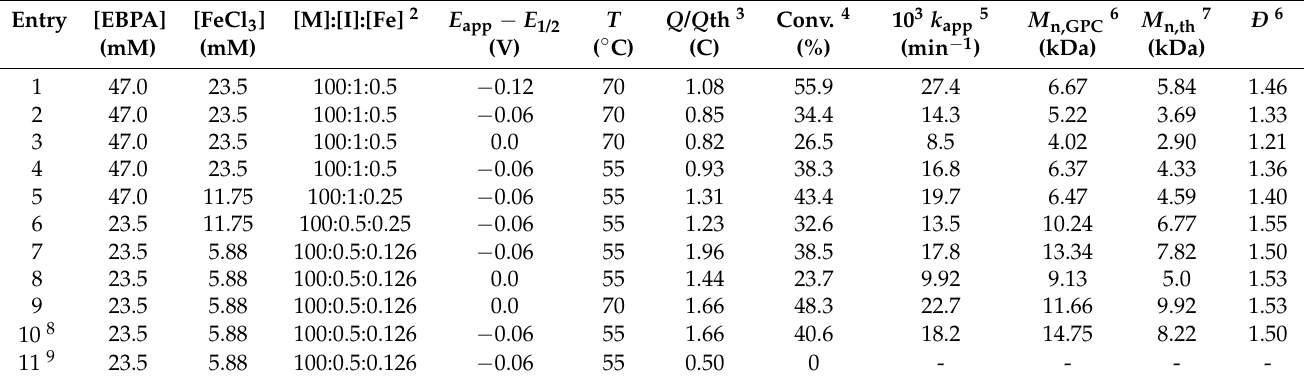
reaction rate. As desired, the conversion increased more than twice while the dispersity remained unchanged (Table 3, entry 9). Table 3. e ATRP of methyl methacrylate (MMA) and butyl acrylate in DMF/monomer (50/50, V/V) +